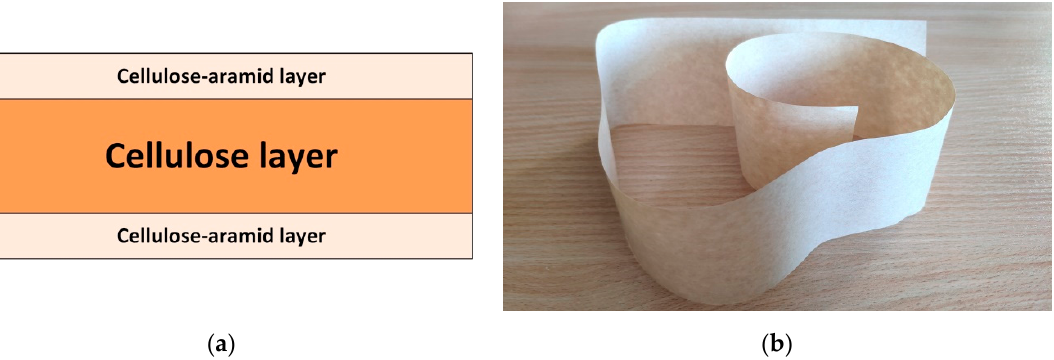
Figure 1. NOMEX ® 910 material structure: ( a ) cross-section; ( b ) photograph of a small sample.